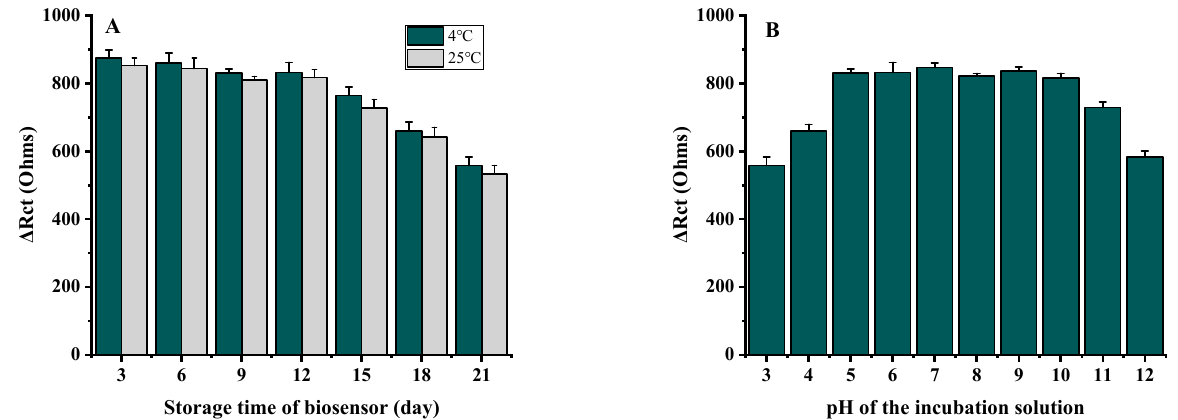
Figure 8. Stability evaluation of biosensors under different conditions. ( A ) Impedance change of biosensors at 4 °C and 25 °C within 21 days. ( B ) Impedance change of biosensors at different pHs from 3 to 12. The data acquisition is the same as in Figure 4.